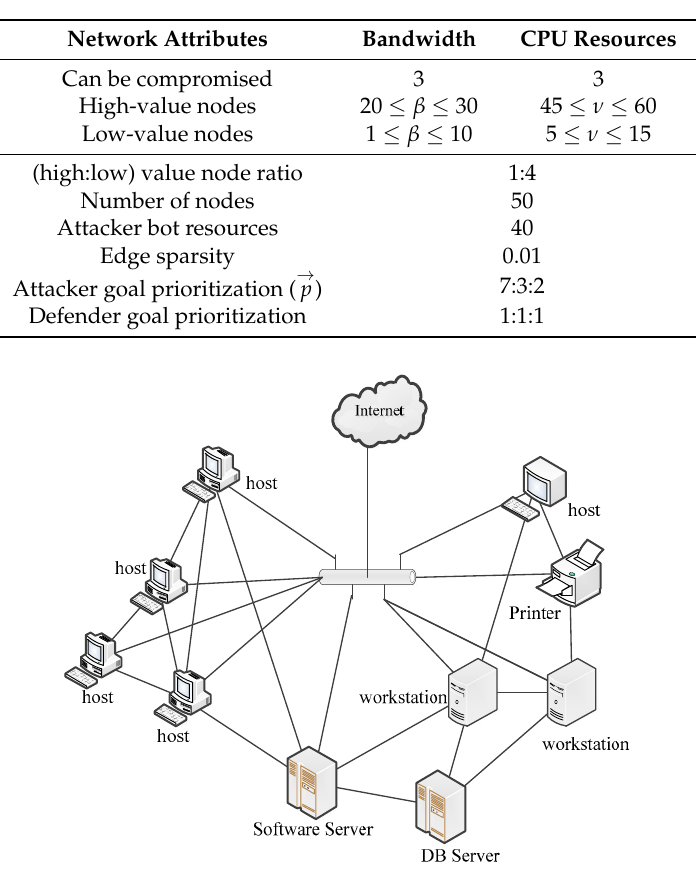
Figure 1. Sample network with 10 nodes.